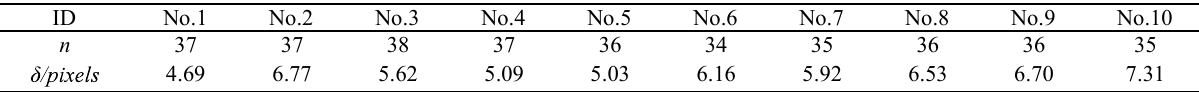
Table 1. The registration accuracy of 10 panoramic images in dataset I